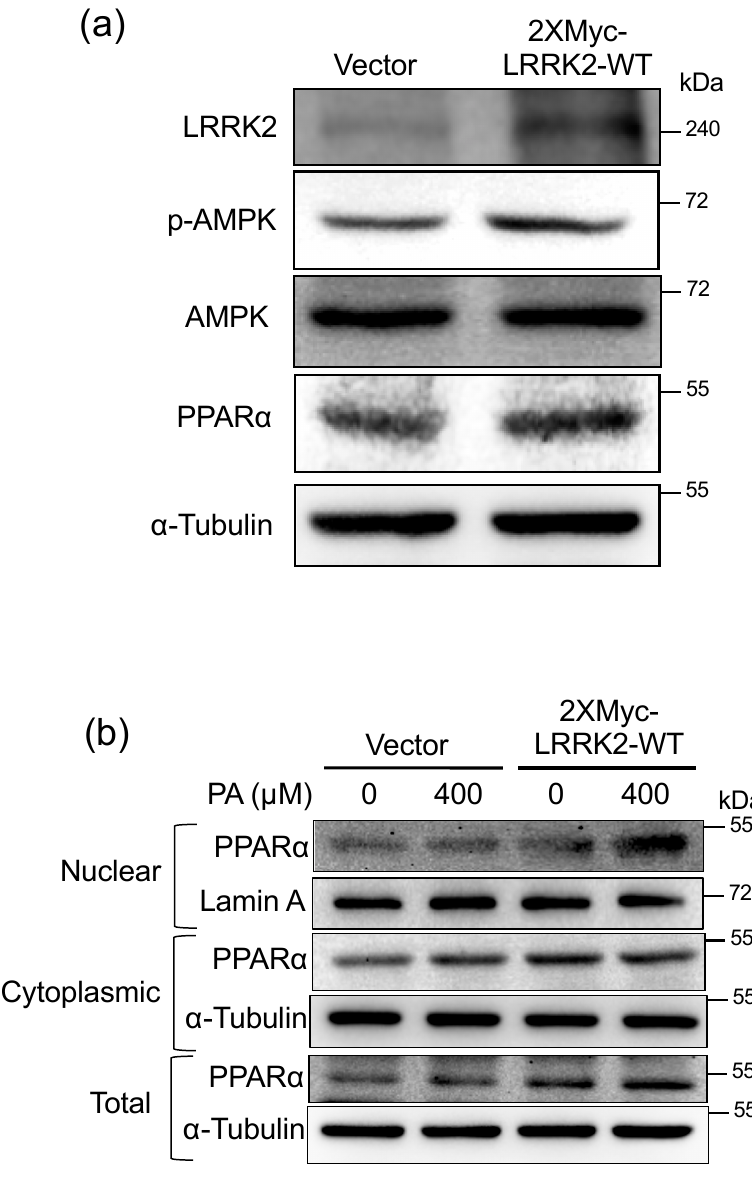
Figure 5. LRRK2 activated AMP-activated protein kinase (AMPK) and peroxisome proliferator-activated receptor α (PPAR α ) in HepG2 cells. ( a ) Western blots were used to analyze the protein levels of LRRK2, p-AMPK, AMPK, PPAR α , and α -Tubulin in the HepG2 cells transfected with vector control or 2XMyc-LRRK2-WT plasmid. ( b ) A western blot was used to analyze the changes in nuclear and cytoplasmic PPAR α in the control and LRRK2-overexpressed HepG2 cells after 0 or 400 µ M PA treatment for 2 h. Lamin A was a loading control for nuclear protein, and α -Tubulin was a loading control for cytoplasmic protein. Vector: vector